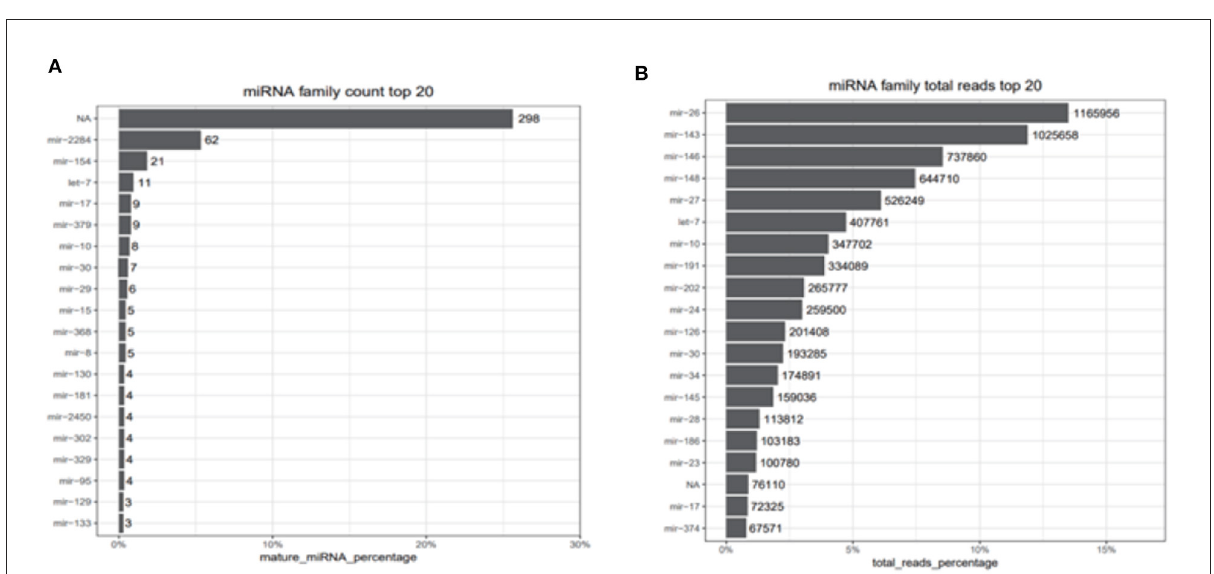
FIGURE2 miRNAs family count top 20 and total reads top reads. (A) Top 20 counts of mature miRNAs from one miRNAs family. (B) Top 20 counts of reads of these miRNAs. NA represents that the reads are consistent with the characteristics of miRNAs but didn’t belong to any miRNA families we